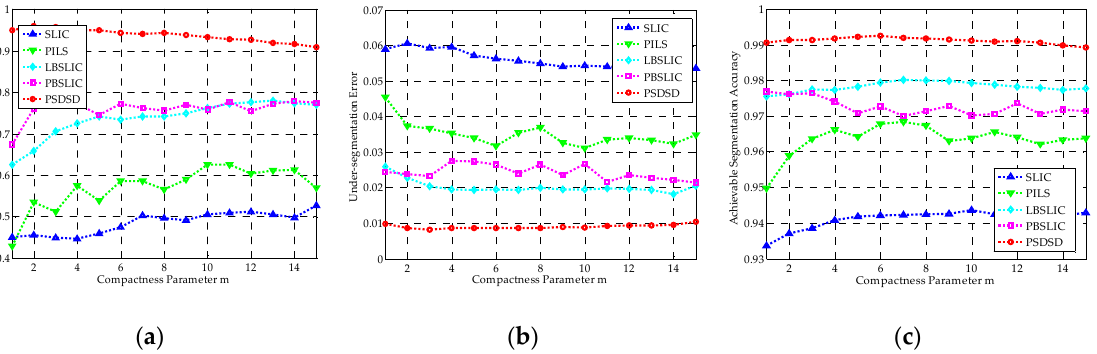
Figure 9. The Boundary Recall (BR), Under-Segmentation Error (USE), and Achievable Segmentation Accuracy (ASA) results for simple linear iterative clustering (SLIC), pixel intensity and location similarity (PILS), likelihood-based SLIC (LBSLIC), patch-based SLIC (PBSLIC), and pixel saliency difference and spatial distance (PSDSD) with K set to 240, v set to 0.0075, and m set between one and 15. ( a ) BR; ( b ) USE; ( c ) ASA.